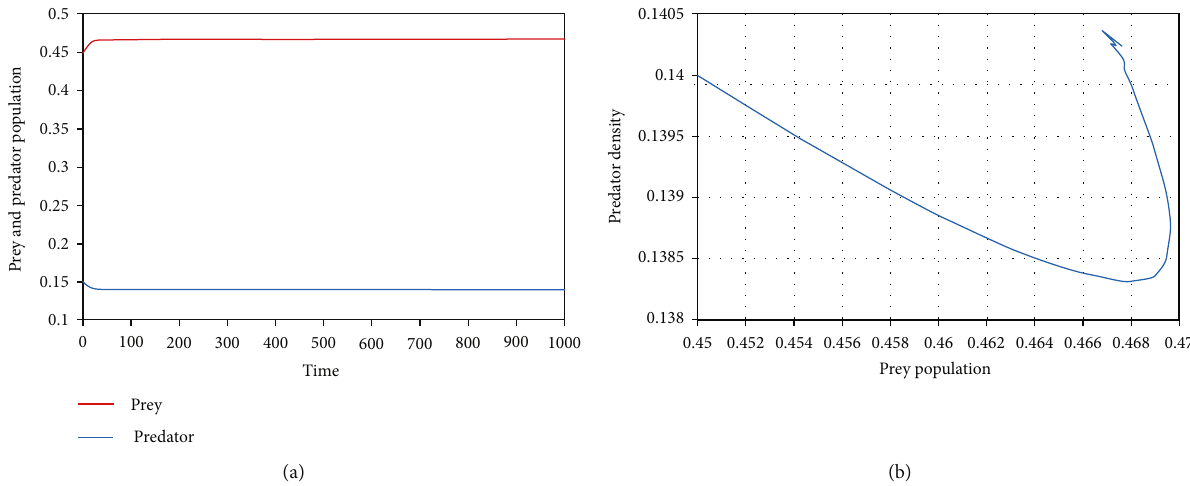
Figure 10: (a) Time series solution and (b) parametric plot of system (4) about the equilibrium point E except H = 0 : 5, c 2 = 0 : 1, c 1 = 0 : 35, α = 0 : 5, and β = 0 : 95